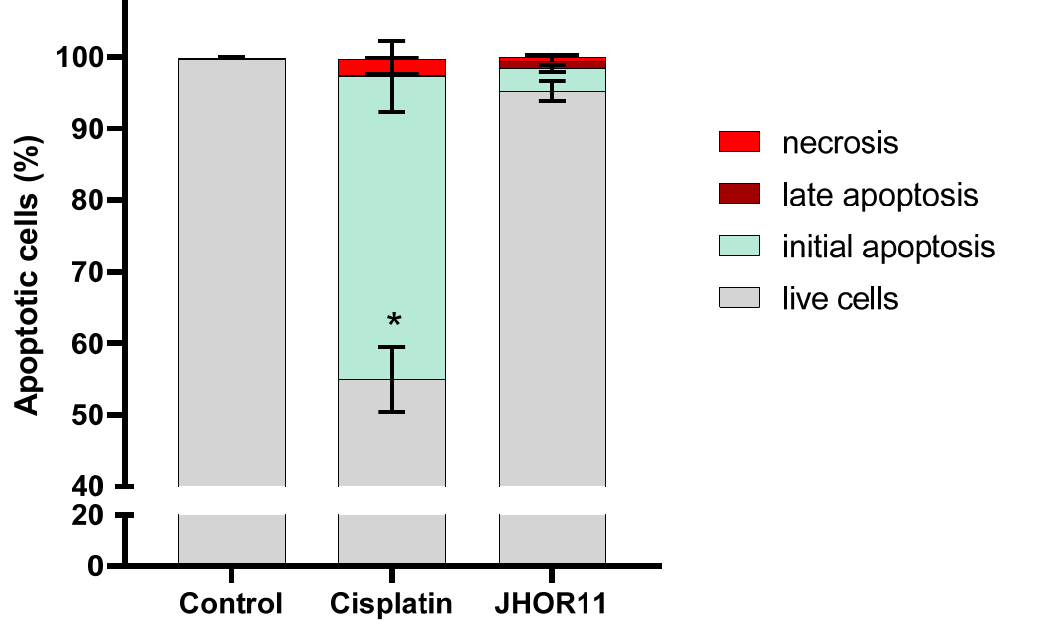
Figure 3. Percentage of apoptotic A2780 cells after 48 h exposure to IC 50 concentration of JHOR11 evaluated by flow cytometry. DMSO 0.1% ( v / v ) was the vehicle control and cisplatin 3.5 µ M was used as positive control. Bars represent the mean ± SD of at least three independent experiments. * p value < 0.05.